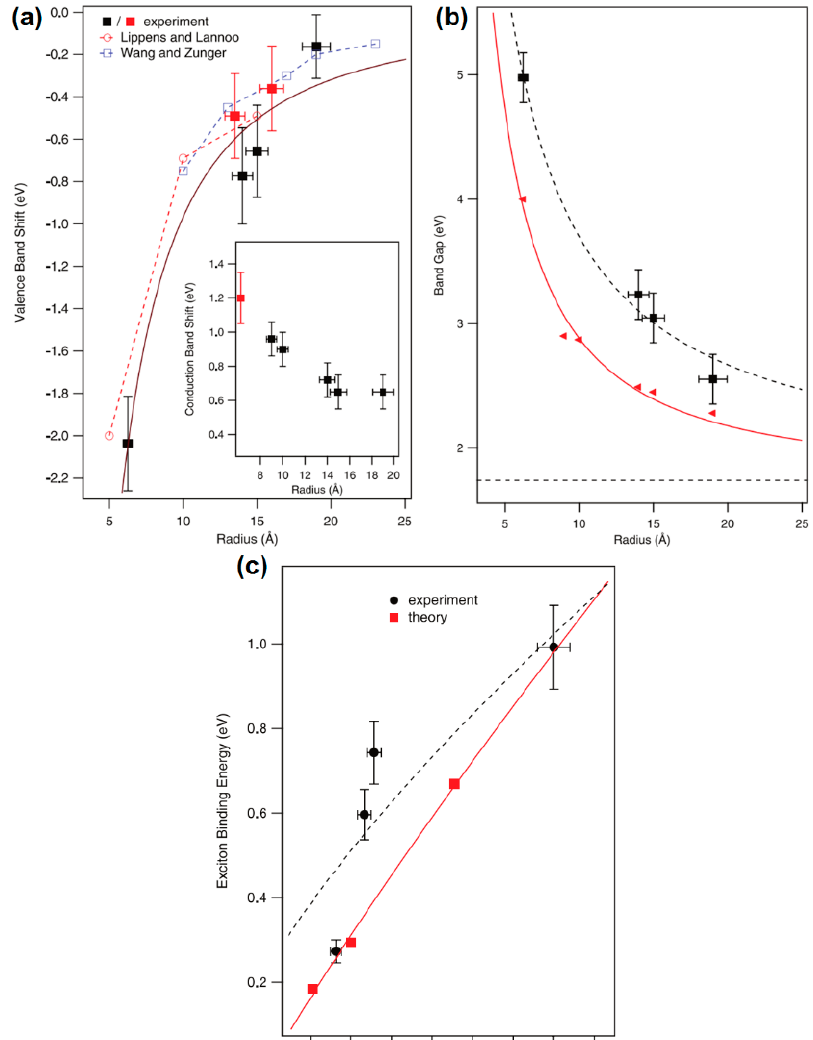
Figure 6. ( a ) Variation in the positions of the valence band and (inset) conduction band extrema as a function of particle radius in CdSe QDs. The black and red filled squares represent the data points for pyridine and thioglycolic acid-functionalized CdSe QDs, respectively, while the open circles and squares represent theoretical values. ( b ) Effect of the CdSe QD particle radius on the electronic bandgap. The black presents the CdSe QD photoemission bandgaps while the red represents the CdSe QD optical absorption band gaps. ( c ) Exciton binding energy of CdSe QDs as a function of particle radius. The black dots represent the CdSe-TOPO QD experimental exciton binding energy while the red squares represent the theoretical values. Adapted with permission from [42]. Copyright 2009 American Chemical Society.